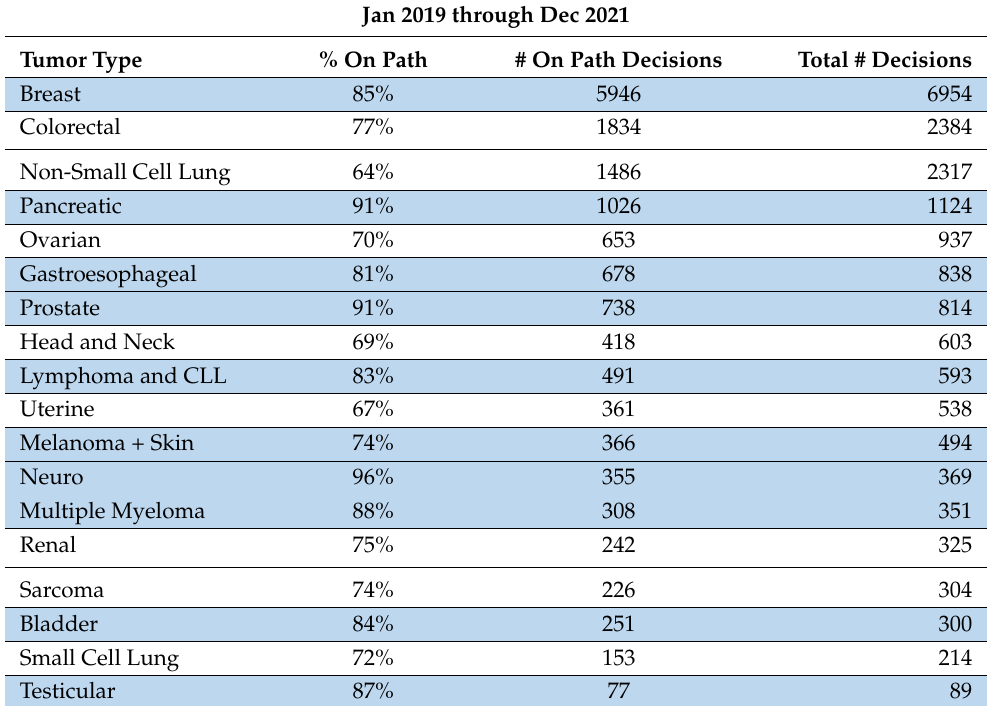
Table 2. Enterprise 3-Year ClinPath Navigation Data: Percent (%) of On-pathway Decisions, total number (#) on-pathway decisions, and total number (#) of decisions by 18 tumor types with >200 decisions or >80% On-pathway rates. Tumors are ranked by the number of decisions from the highest number for breast cancers down to the lowest for testicular tumors. A blue highlight indicates On-pathway rates > 80%. Tumor type CLL is chronic lymphocytic leukemia, Neuro refers to brain